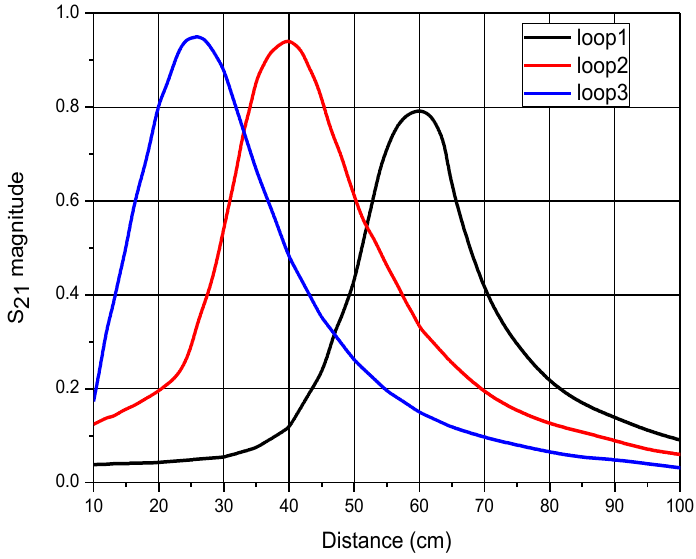
Figure 9. Simulated S 21 magnitude for different loops with varying d 23 in the Case 2 system.